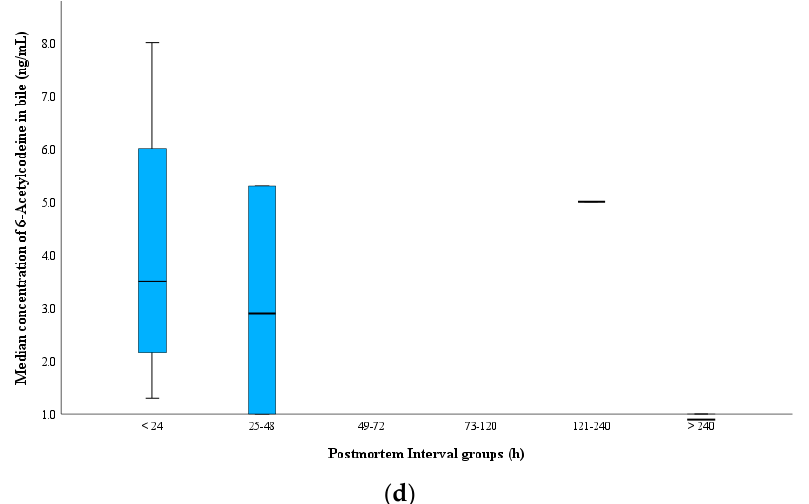
Figure 4. Distribution of 6-AC in the 97 heroin-related fatality cases according to postmortem interval time group ( a ) blood with sodium fluoride (ng/mL), ( b ) urine (ng/mL), ( c ) vitreous humor and ( d ) bile. The whiskers correspond to the smallest and largest value within 1.5 times the interquartile range, and circles (outlier) symbolize values exceeding at least 1.5 times the interquartile range and extremes (asterisks) correspond to values exceeding at least 3.0 times the interquartile range (this description is applied to the remaining box-plot figures).